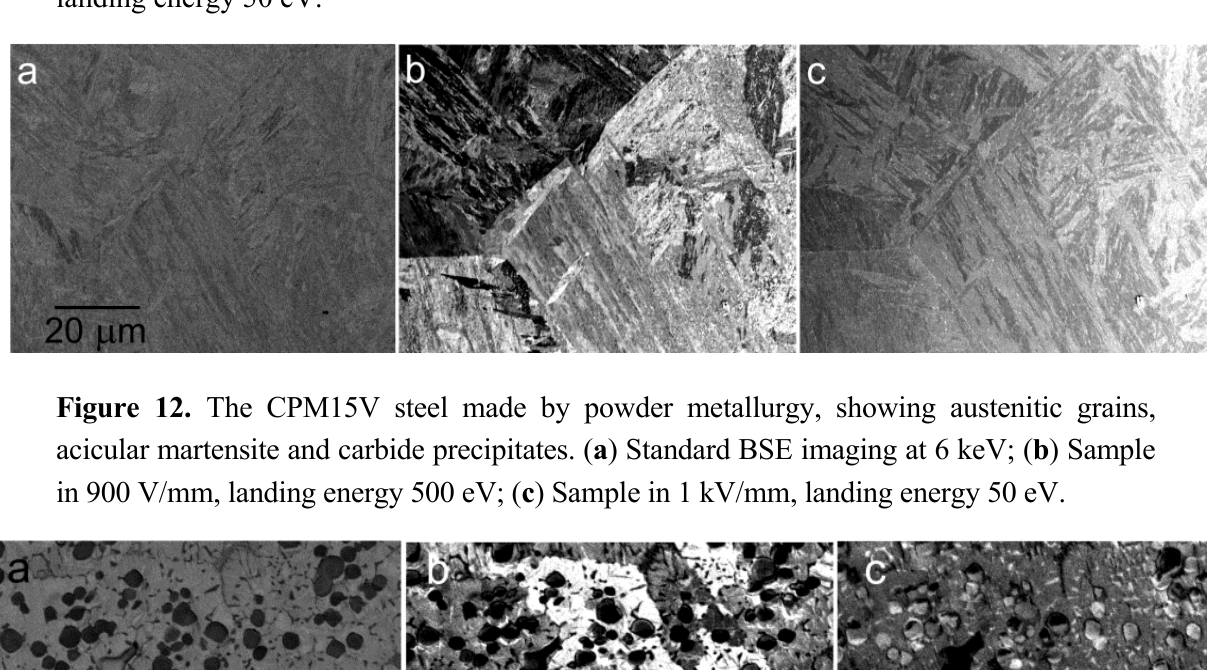
Figure 11. The CB2 steel of an acicular martensite structure. ( a ) Standard BSE imaging at 6 keV; ( b ) Sample in 900 V/mm field, landing energy 500 eV; ( c ) Sample in 1 kV/mm, landing energy 50 eV.